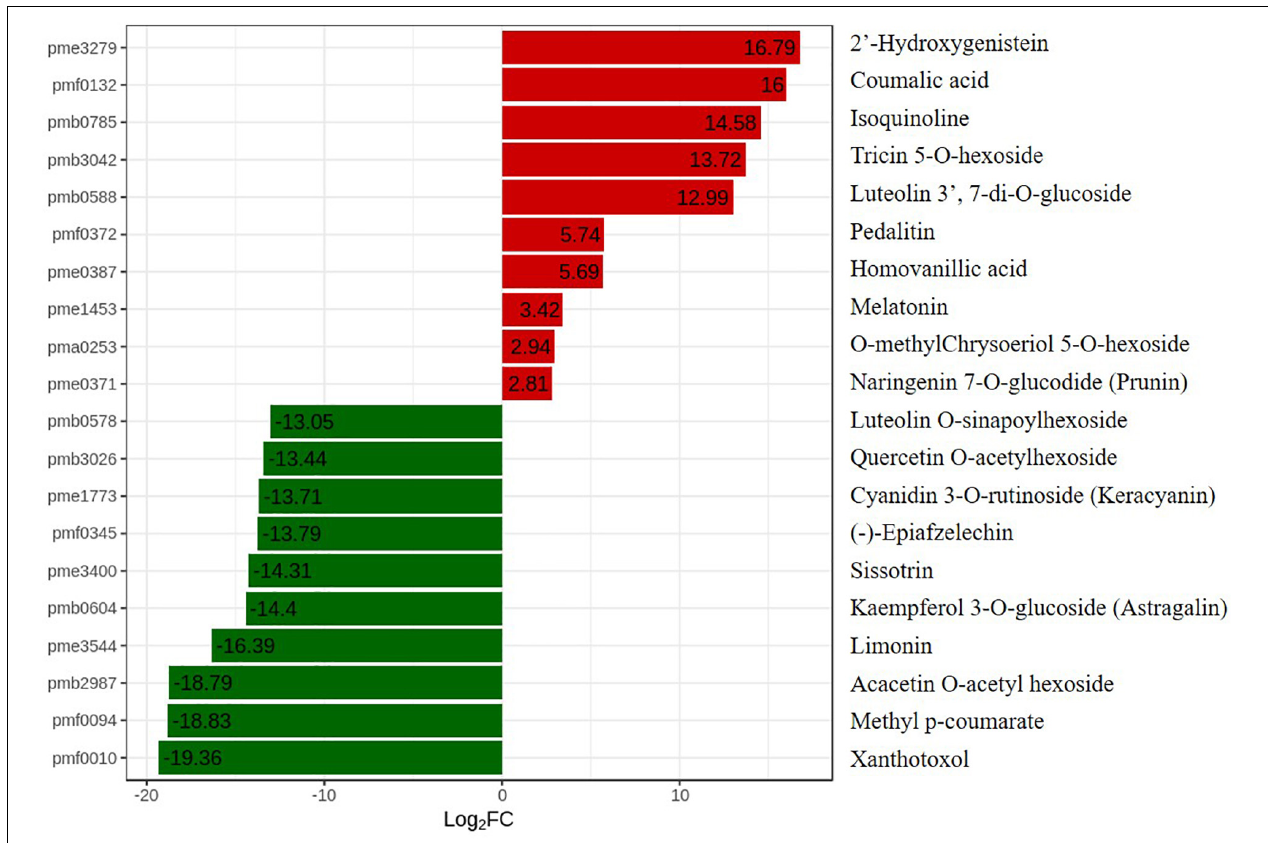
FIGURE 8 | The top ten upregulated and downregulated metabolites between WT plants and OE-MsASMT1 transgenic plants. Red represent the upregulated metabolites in OE-MsASMT1 transgenic plants; green represent the downregulated metabolites in OE-MsASMT1 transgenic